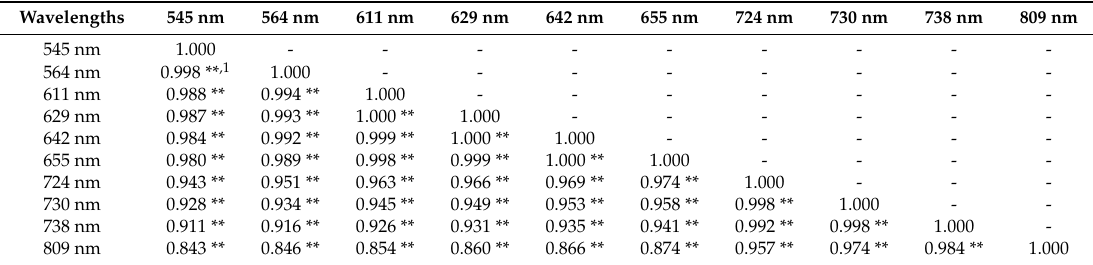
Table 2. Pearson’s linear correlation coefficients and probability levels among 10 selected wavelengths by SPA (successive projections algorithm).